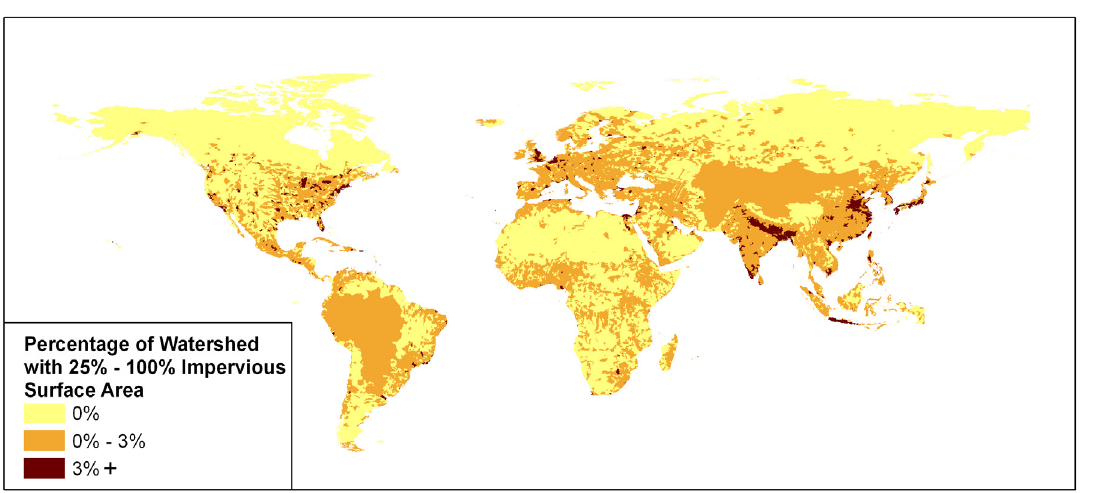
Figure 12. Percentage of watershed area in the damaged category - with 25% or more constructed impervious surface area. Note that the Hydro 1K drainage basins used in the assessment does not include the watersheds of